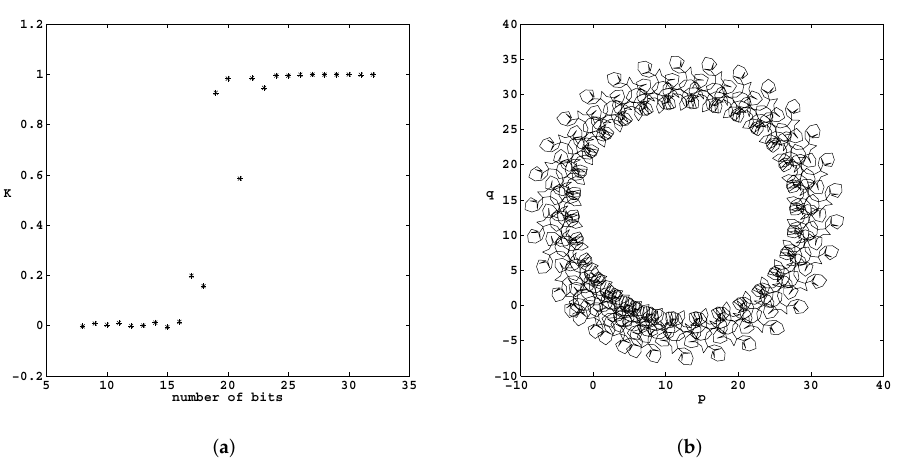
Figure 7. The 0-1 test results: ( a ) K values for various numbers of bits of { Y 0 j } (see Figure 2) between 8 and 32 (horizontal axis) and the sequence of 7th bits from a logistic map with µ = 3.99; ( b ) variables q − p for a sequence of 7th bits when the total length of each number is 21 bits. K = 0.6038 (see Figure 6a for number of bits = 21).